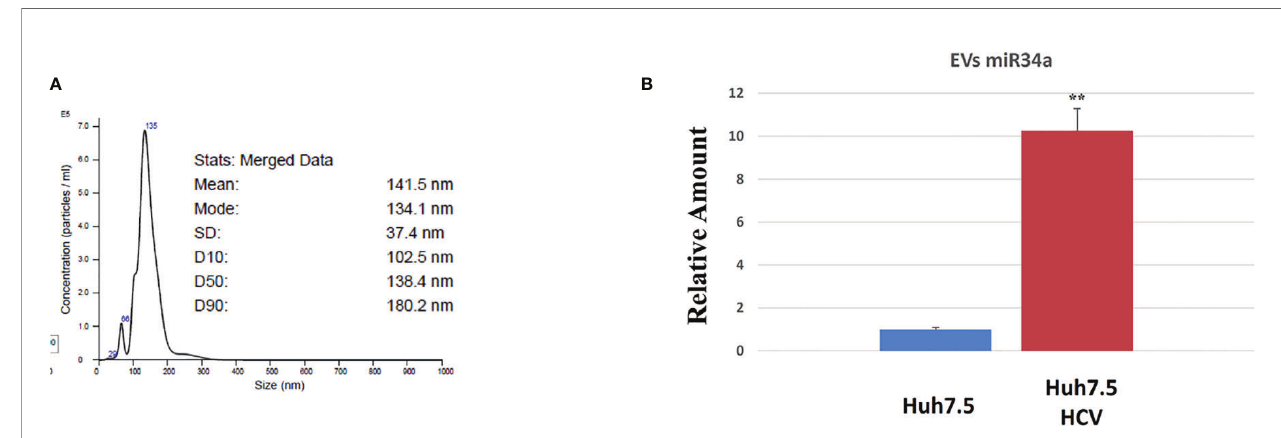
FIGURE 5 | Characterization of Huh7.5 EVs by nanoparticle tracking analysis (NTA) and digital PCR. (A) Representative NTA graphs of EV samples obtained after differential ultracentrifugation of secretome, showing size diameter (nm) of particle populations. (B) Digital PCR analysis showing the expression of miR34a after HCV infection vs. control The reported data are representative of experiments performed in triplicate on three different samples (**p value ≤